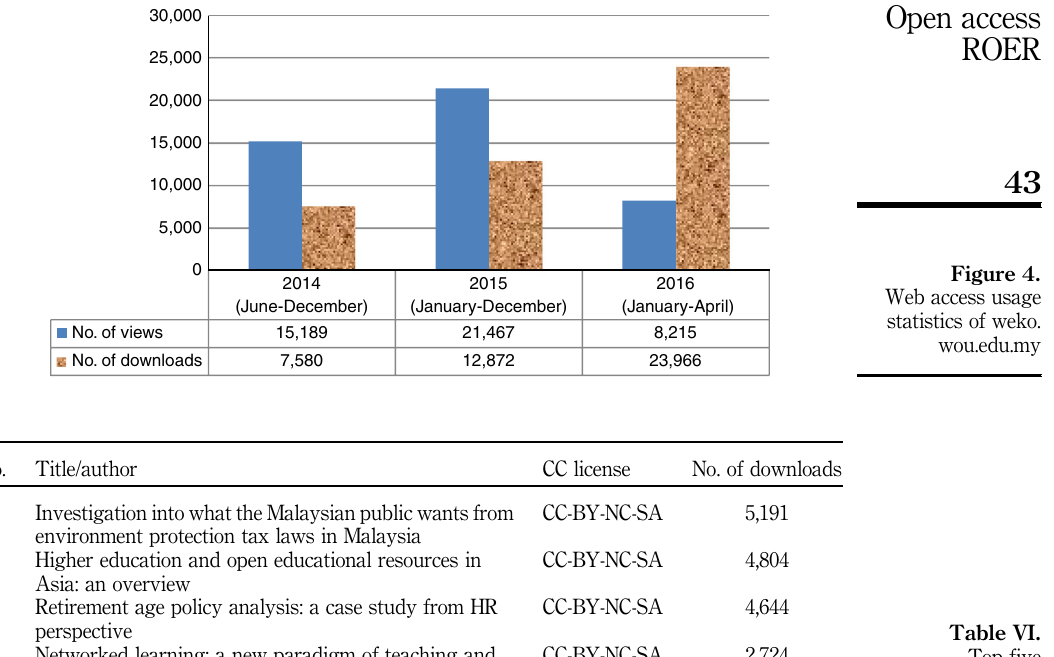
downloads from weko.wou.edu.my